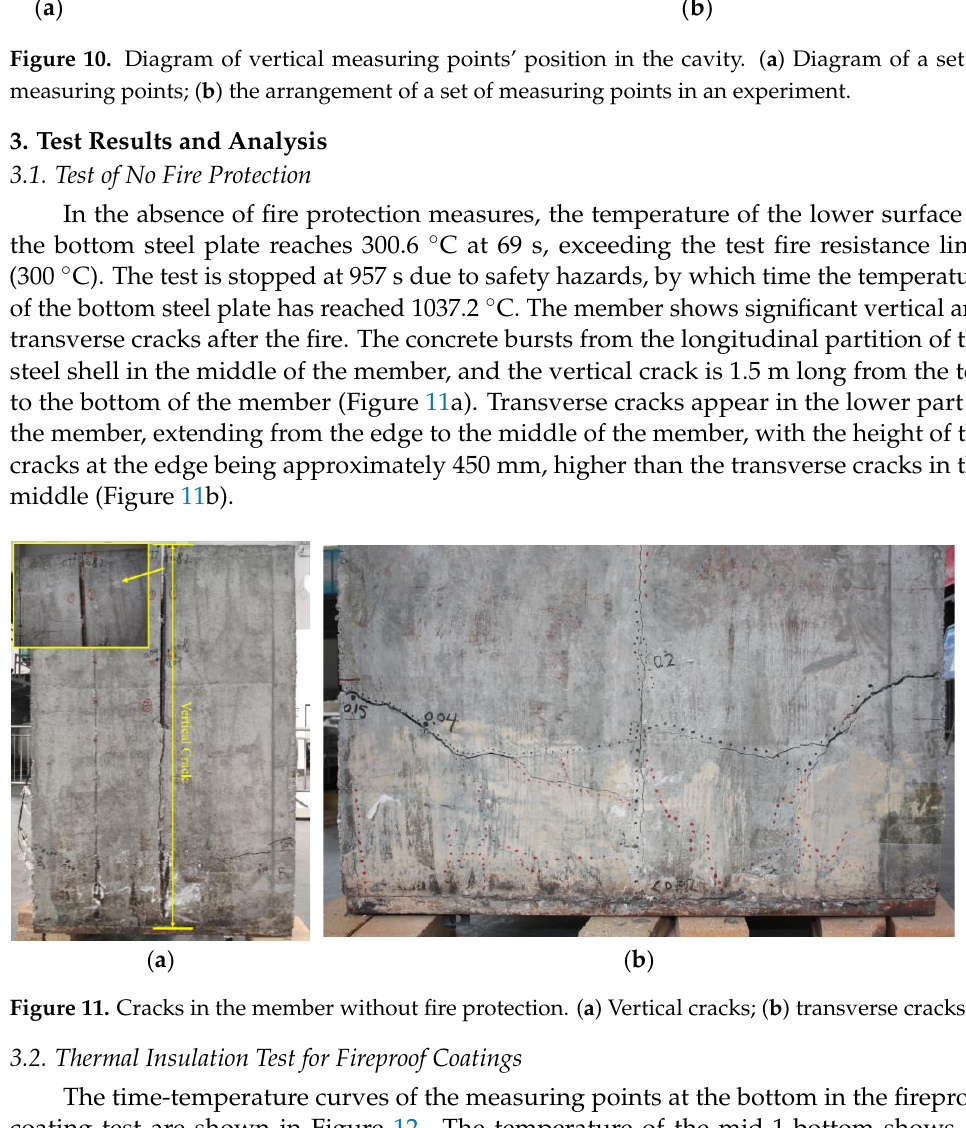
Figure 10. Diagram of vertical measuring points’ position in the cavity. ( a ) Diagram of a set of measuring points; ( b ) the arrangement of a set of measuring points in an experiment.